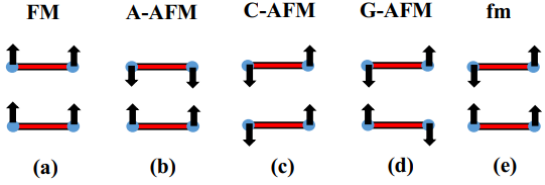
Fig. 2. Five different collinear magnetic configurations at the edges, namely, the FM (a), A-AFM (b), C-AFM (c), G-AFM (d), and fm (e)